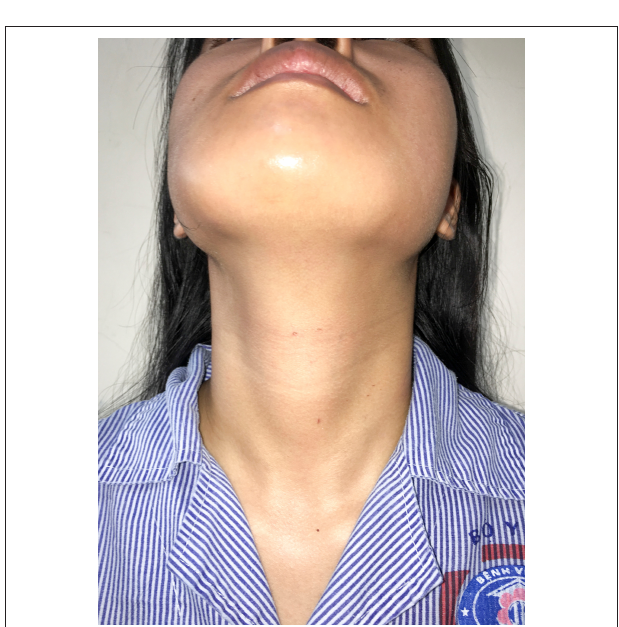
FIGURE 3 | Cosmetic results after surgery 5 days (16-year-old female patient with thyroid cancer of the right lobe pT1aN0M0).